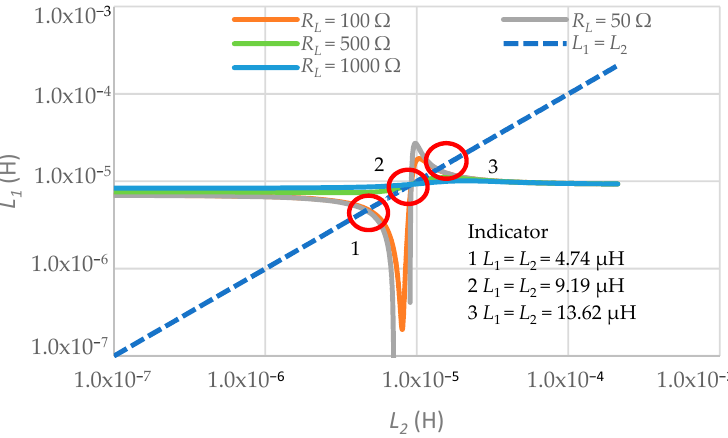
Figure 4. Relationships between L 1 and L 2 as a parameter of R L